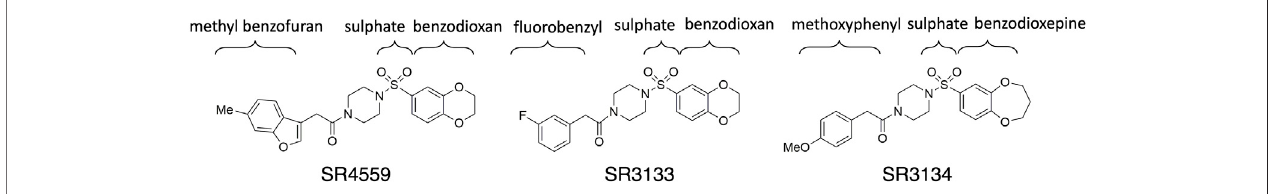
FIGURE 2 | The 2D sketches of the three sulfonyl piperazine (SPZ)